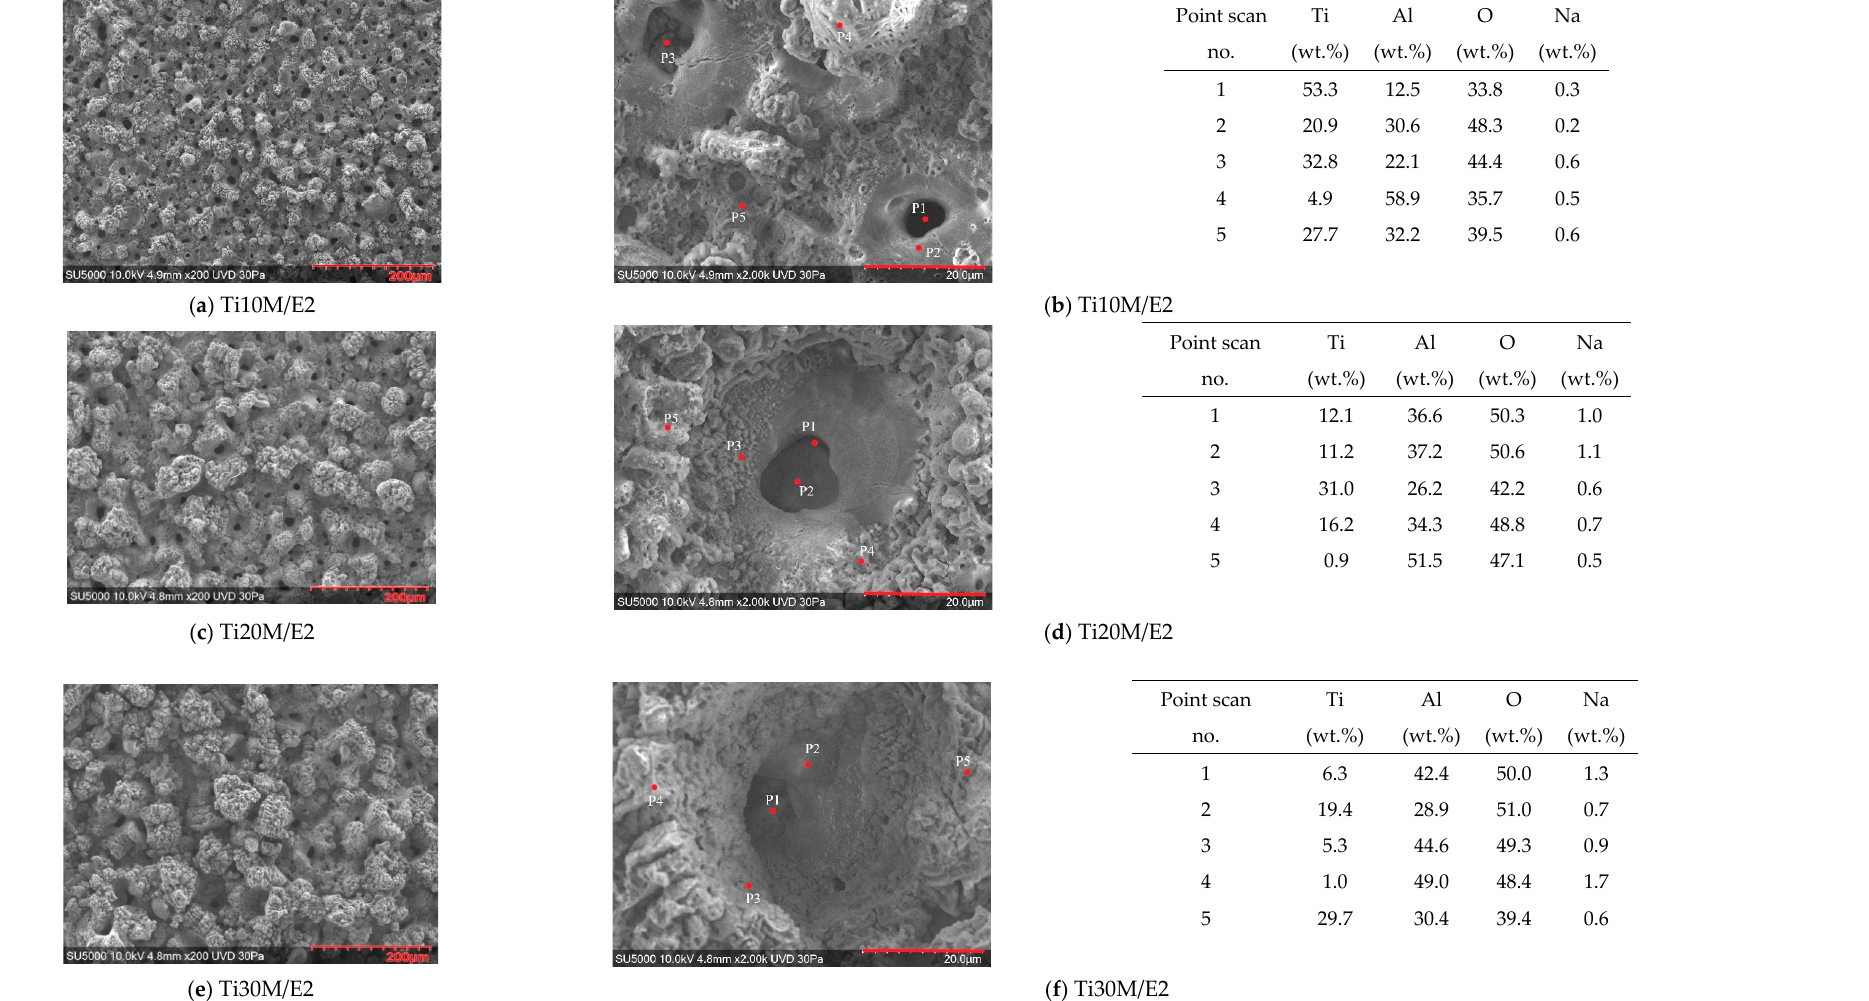
Figure 6. SEM images of the layers grown in E2 electrolyte after 10, 20 and 30 min treatment period: low magnification ( a , c , e ); high magnification and EDS analysis points ( b , d , f ); point element mass concentrations (wt.%).